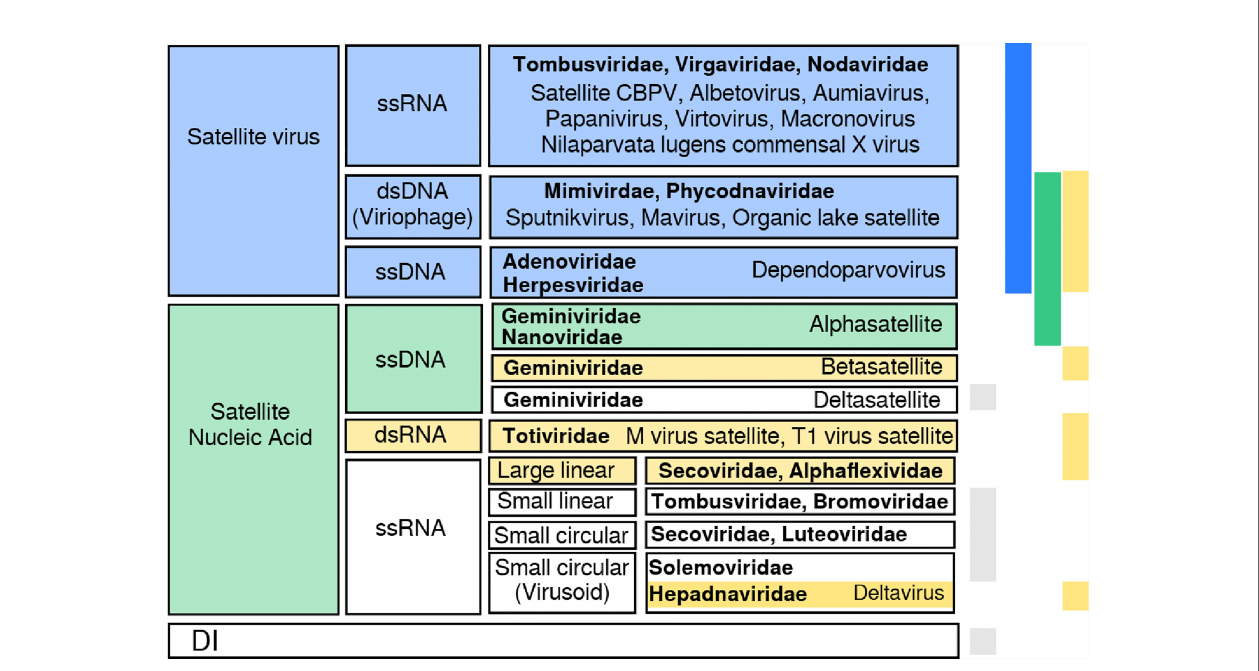
FIGURE 1 | Summary of classes of satellite viruses. There is no straightforward classi fi cation of satellites, although distinguishable groups come to light when looking at the genetic material, helper virus family, host, or coded proteins. Here we show a possible classi fi cation into two groups, depending on whether they code for a capsid protein (satellite viruses) or not (satellite nucleic acid). Satellite viruses comprise plant satellites with jelly roll capsid proteins, dependoparvovirus and viriophages (3, 4). Satellite nucleic acids include a / b -satellites and Seconviridae satellites coding for a replicase or a replication helper protein; M virus satellite expresses a toxin and HDV codes for an antigen. This group includes non-coding — circular — ssDNAs (5) and RNAs with a compact folded structure with ribozyme activity (6, 7). Colors on the right bars show the protein each satellite codes for: capsid (blue), replicase (green), other (yellow). Grey stands for no coded protein. Helper virus families are shown in bold font; DI stands for defective interfering genomes (e.g., coated like defective interfering particles or